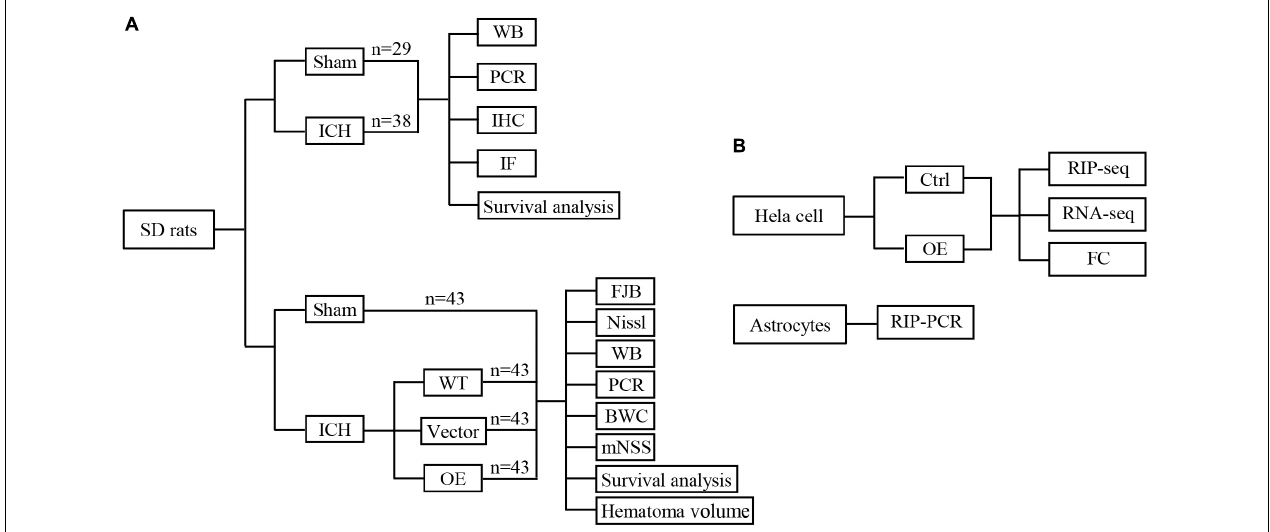
FIGURE 1 | Conceptual illustrations of the experimental design. Flow diagram of in vivo (A) and in vitro (B)